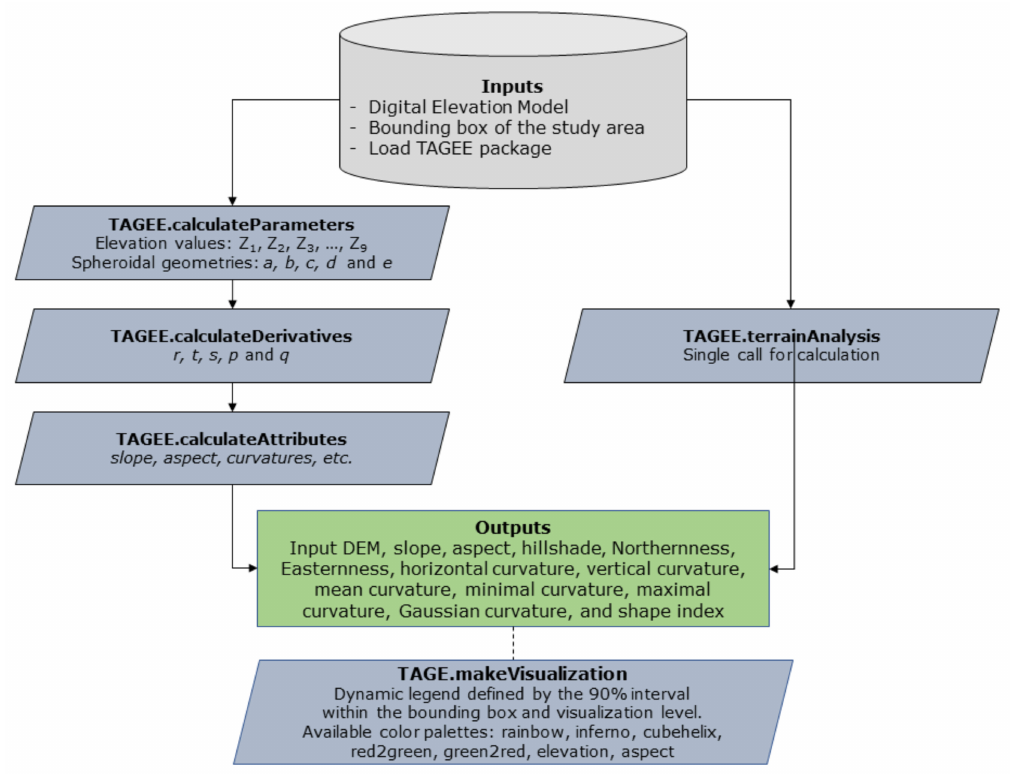
Figure 2. TAGEE modules for calculating terrain parameters, derivatives, and